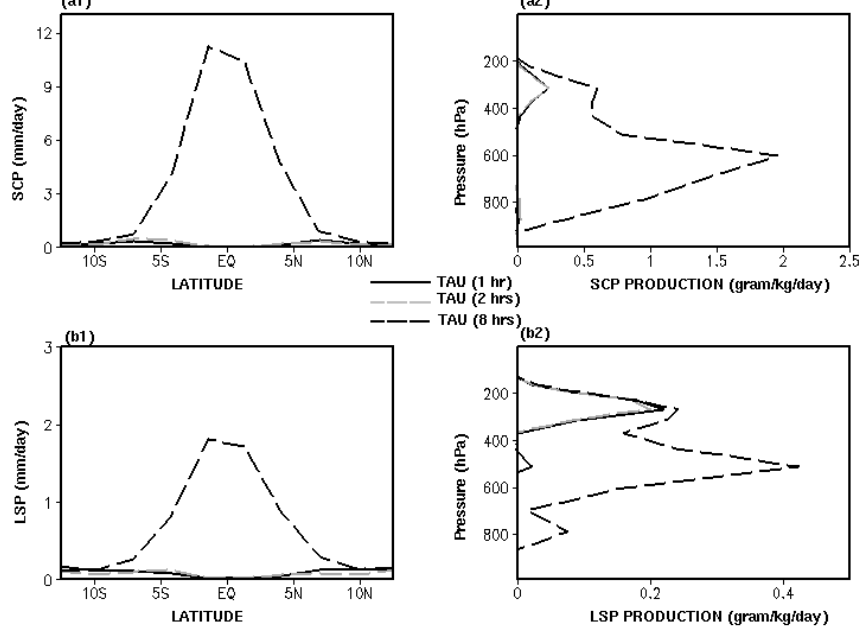
Fig. 6. Time mean quantities with TAU (1h), TAU (2h), and TAU (8h). (a1) Zonal averaged SCP, (b1) Zonal averaged LSP, (a2) Vertical distribution of the area averaged SCP production over 0 ◦ E to 360 ◦ E and 7 ◦ S to 7 ◦ N, and (b2) vertical distribution of the area averaged LSP production over 0 ◦ E to 360 ◦ E and 7 ◦ S to 7 ◦